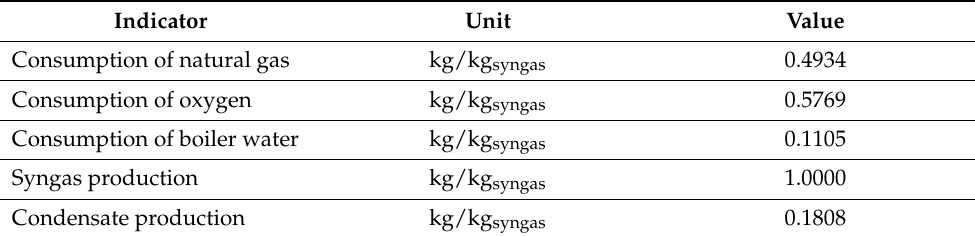
Table 2. Basic indicators for syngas consumption and